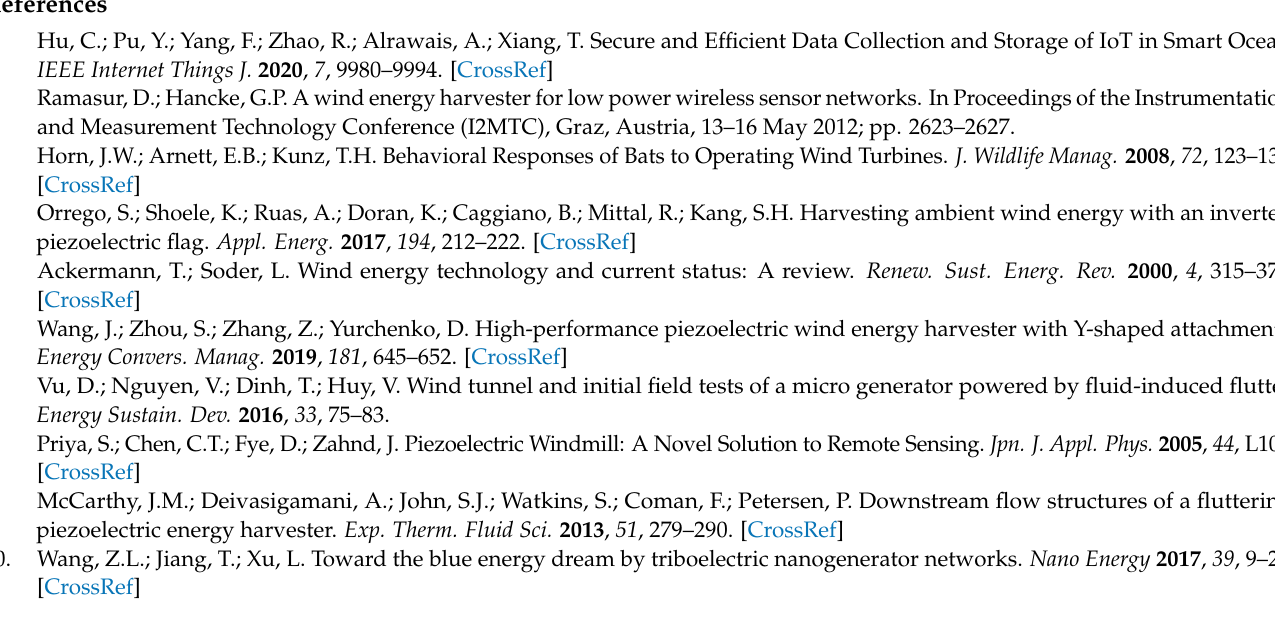
Figure A4. Effects of the size of PTFE ball on the output of the SC-TENG.